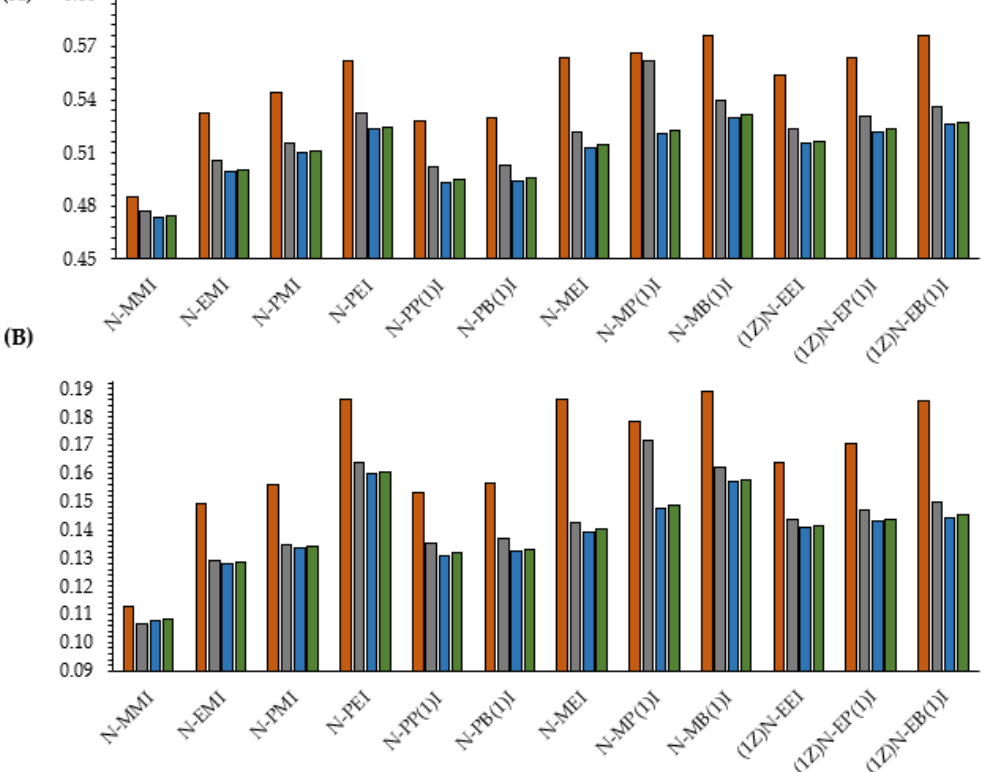
Figure 9. ΔN transferred during corrosion protection of Fe ( A ) and Cu ( B ) in gaseous (orange bars), aqueous (grey bars), HCl of 1 mol/dm 3 (blue bars) and HCl of 2 mol/dm 3 (green bars) environments .